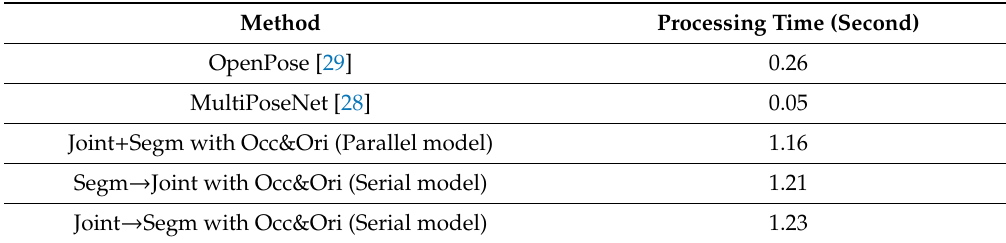
Table 7. Comparison for processing time of proposed models and other